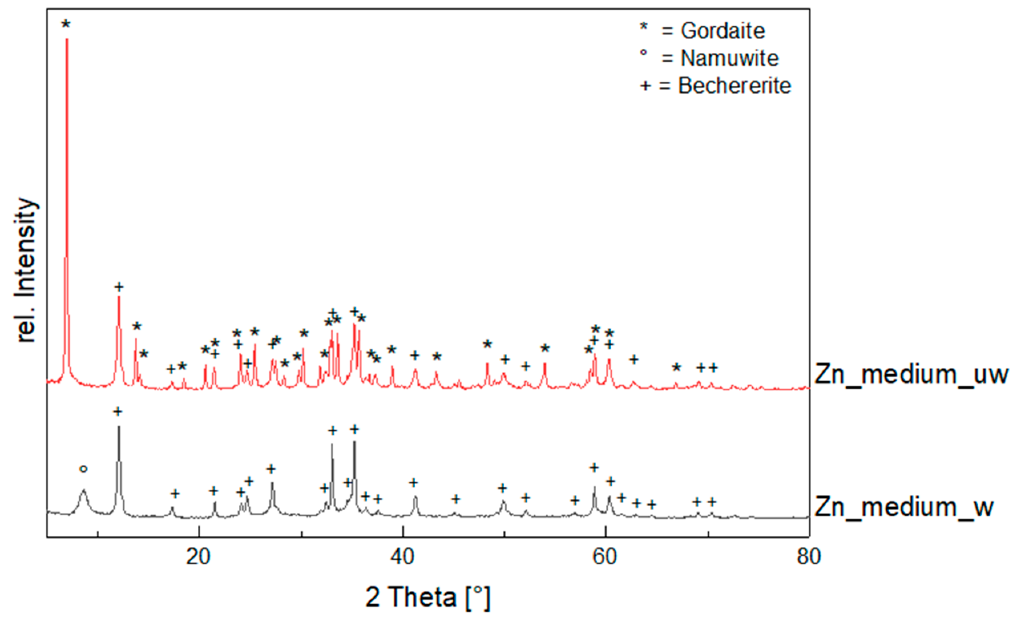
Figure 7. XRD pattern (Cu K α 1 ) of the washed (w) and unwashed (uw) precipitates of experiment Zn medium (exp. set 1).